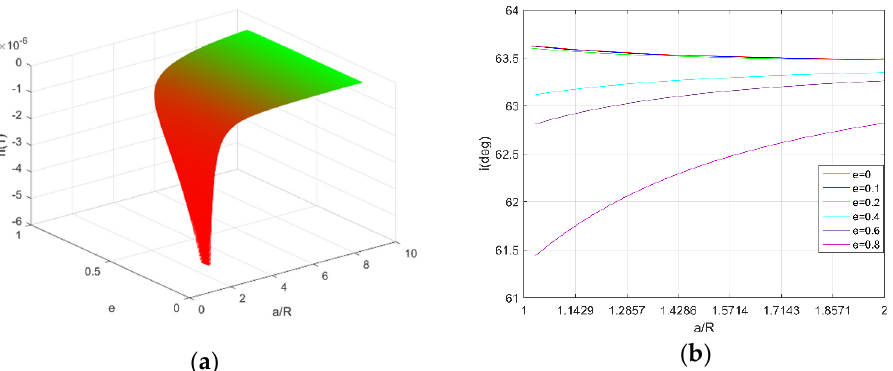
Figure 6. ( a ) Variation of h ( 1 ) as a function of the semi-major axis a and the eccentricity e. ( b ) Variation of the critical inclination i as a function of the semi-major axis for different values of the eccentricity.